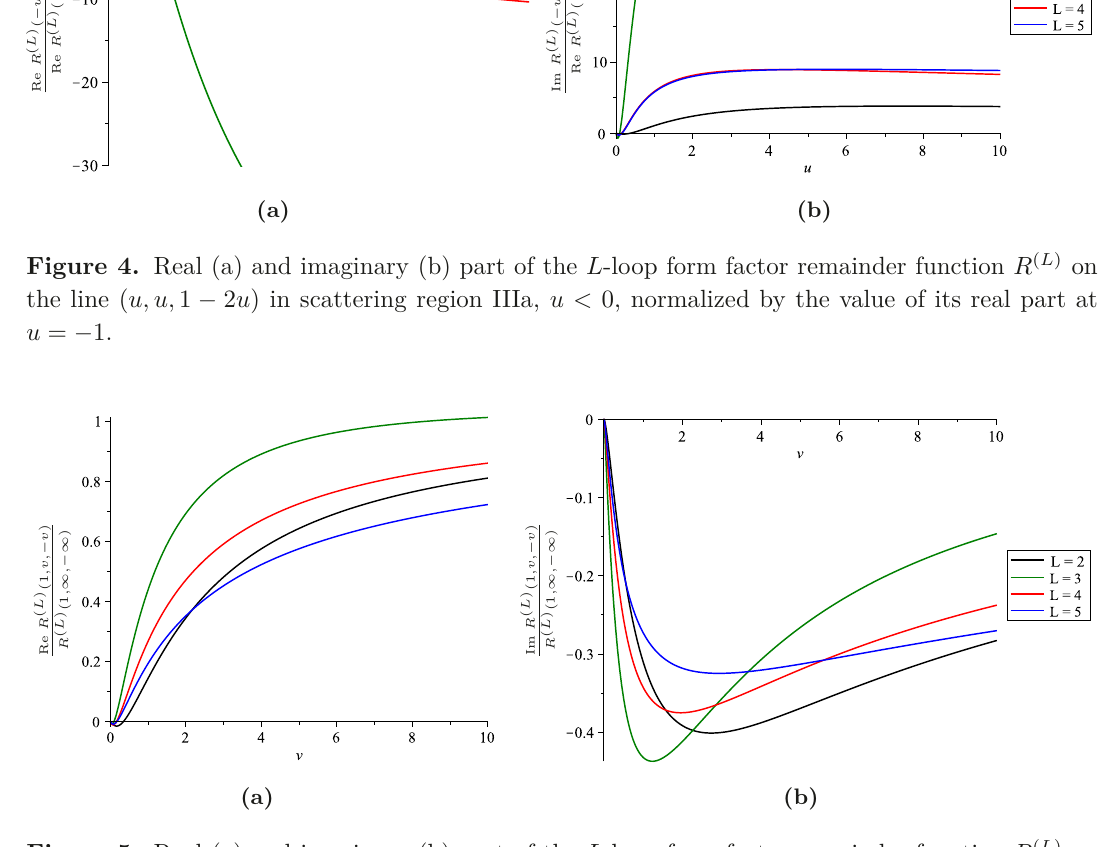
Figure 5. Real (a) and imaginary (b) part of the L -loop form factor remainder function R ( L ) on the line u = 1 in scattering region IIa, v > 0 , normalized by its (real) value at v = ∞